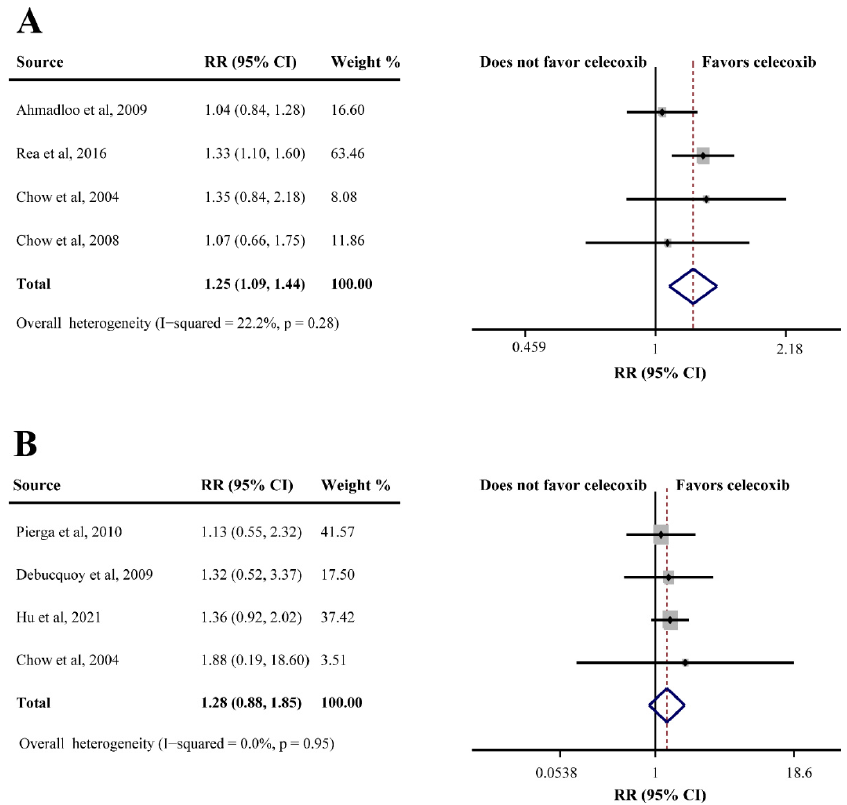
Figure 5. Efficacy of celecoxib-combined neoadjuvant therapy on objective response rate (ORR) ( A ) and pathological complete response (pCR) ( B ). RR: relative risk; CI: confidence interval [30,43,45,53–